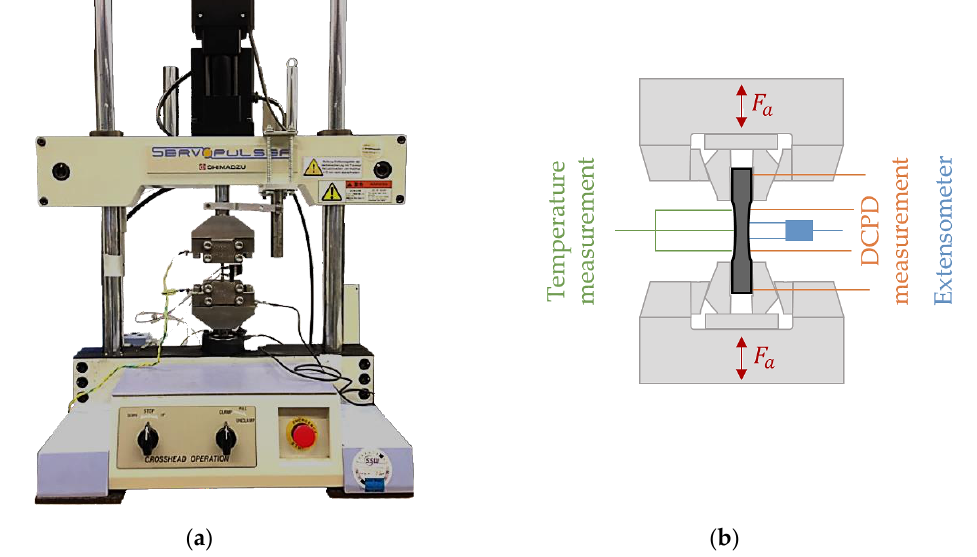
Figure 4. Test setup for fatigue tests: ( a ) servohydraulic testing system Shimadzu EHF-LV20; ( b ) schematic installation of the measuring technique.